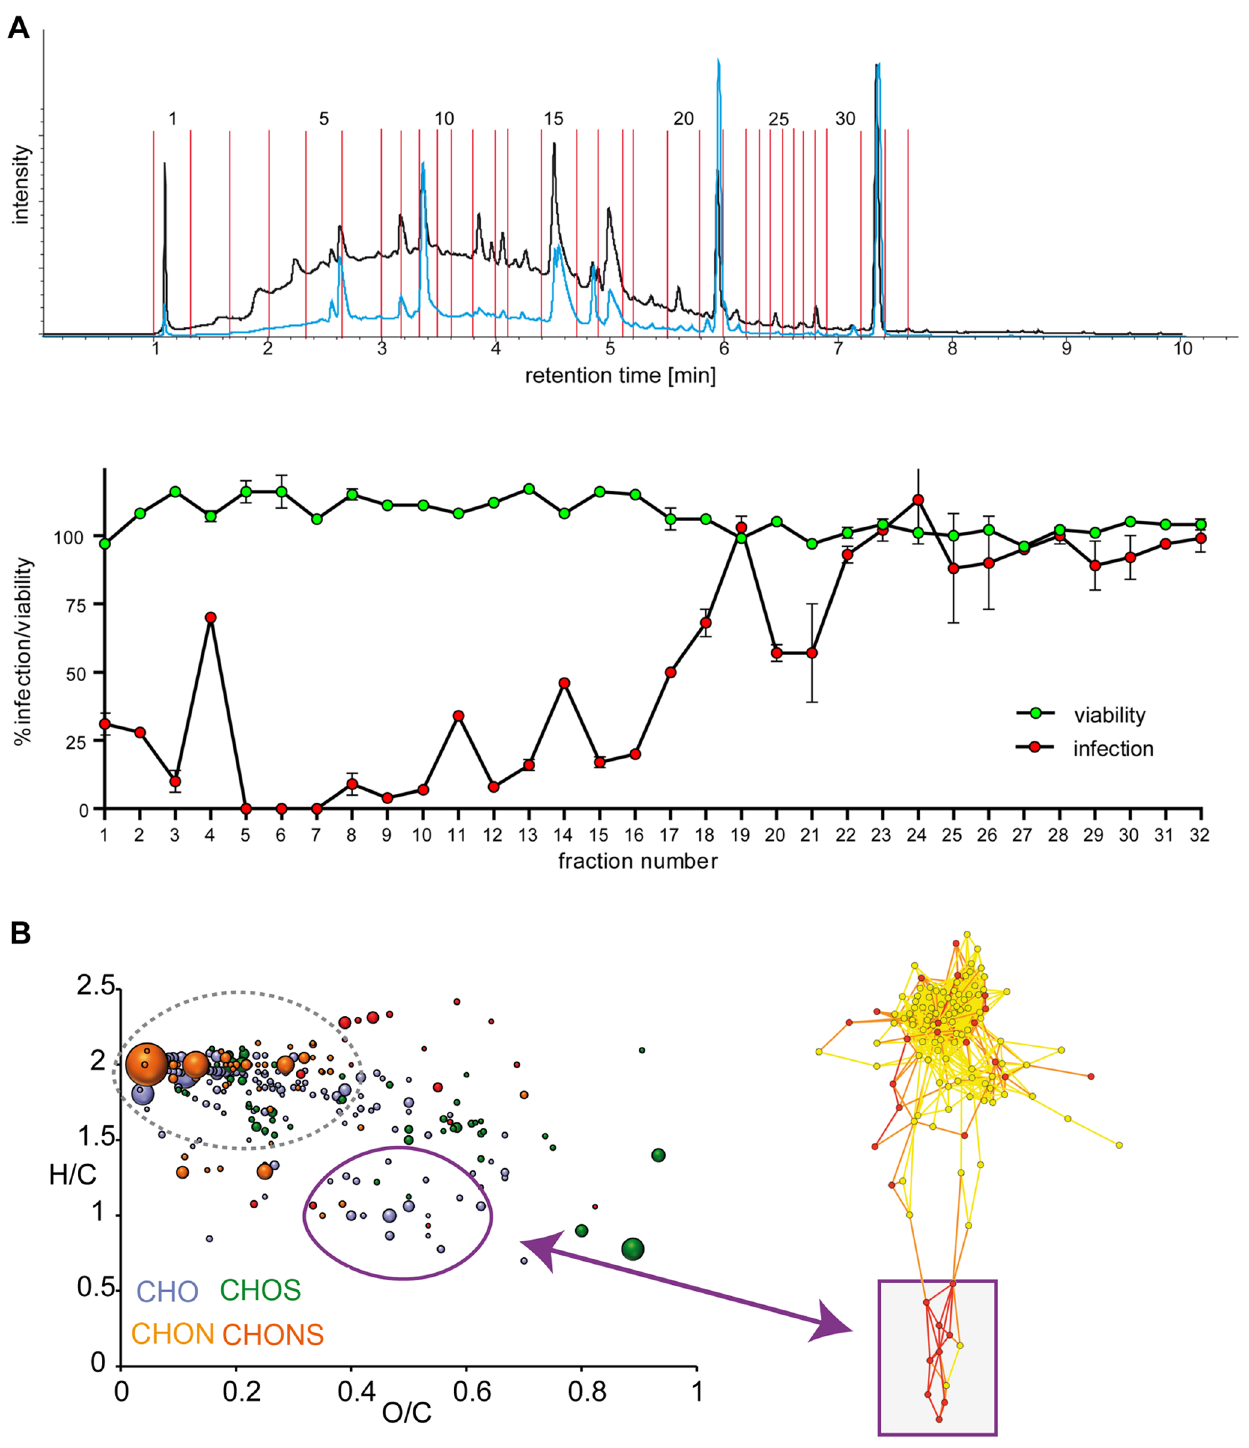
Figure 5. Chemical analysis of anti-HIV activity of PS extract. PS extract was purified by solid phase extraction and separated by UPLC- chromatography. Fractions were analyzed for anti-HIV activity with the EASY-HIT assay and for effects on cell viability by MTT assay. Chemical structures in fractions were analyzed by a combination of ICR/FTMS (Ion Cyclotron Resonance/Fourier Transformation Mass Spectrometry), structural data-mining, statistical analysis and mass network analysis. A , Profiling of anti-HIV activity shows inhibitory activity in multiple UPLC-fractions. The UV- chromatogram (top) displays the signal intensities at 289 (black graph) and 330 (blue graph) nm used for peak-oriented identification of PS fractions. The profile below the UV-chromatogram shows a plot of the anti-HIV-1-activity (red data points) and cell viability (green data points) of the corresponding UPLC fractions. B , Chemical diversity of anti-HIV activity. The van Krevelen diagram at the left shows the chemical diversity of compounds discriminating fractions with strong anti-HIV-1 activity (3, 5-10, 12) from non-active fractions (19, 22-32). Discriminatory compounds included groups of polyphenolic compounds like flavonoids and leuco-anthocyanidins (encircled in violet) as well as aliphatic oxygen poor, hydrogen